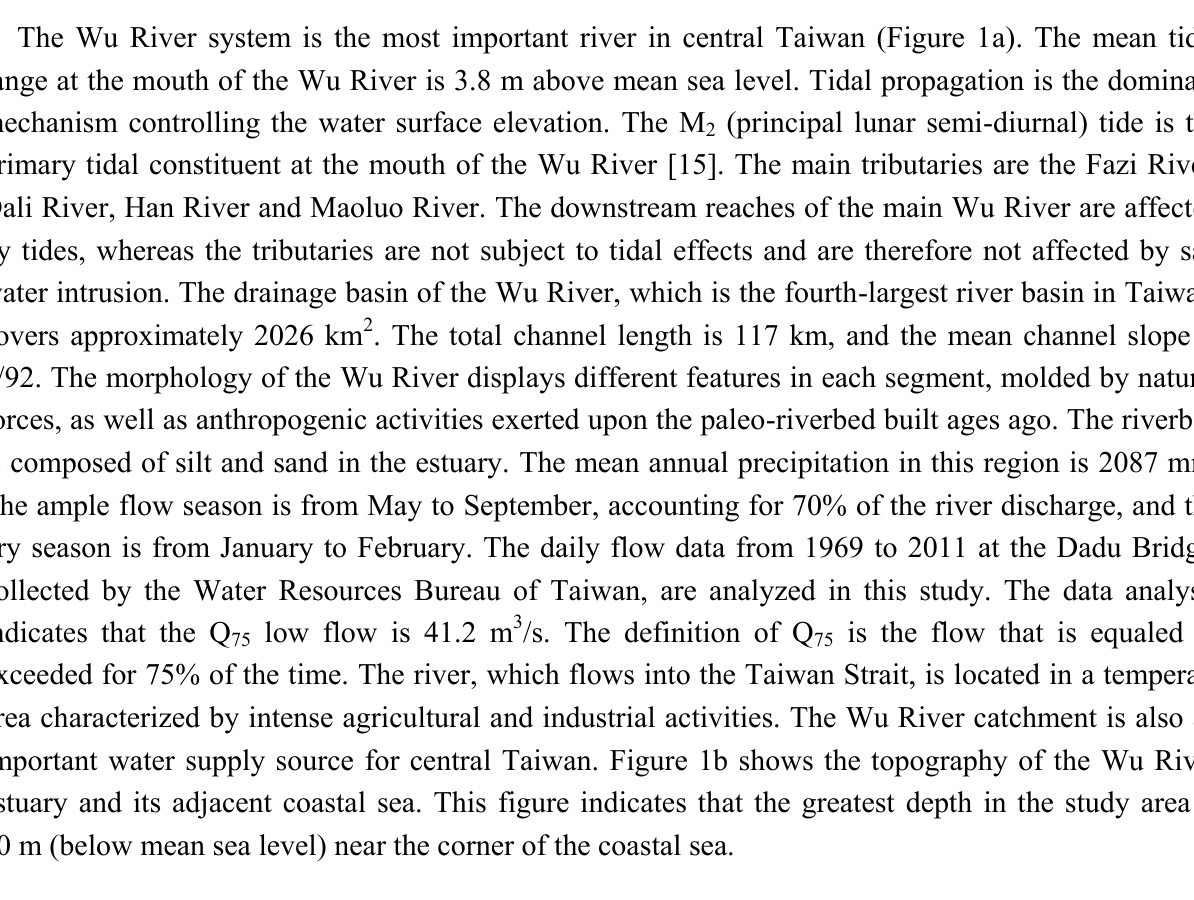
Figure 1. ( a ) Map of the Wu River system and ( b ) bathymetry of the Wu River estuary and adjacent coastal